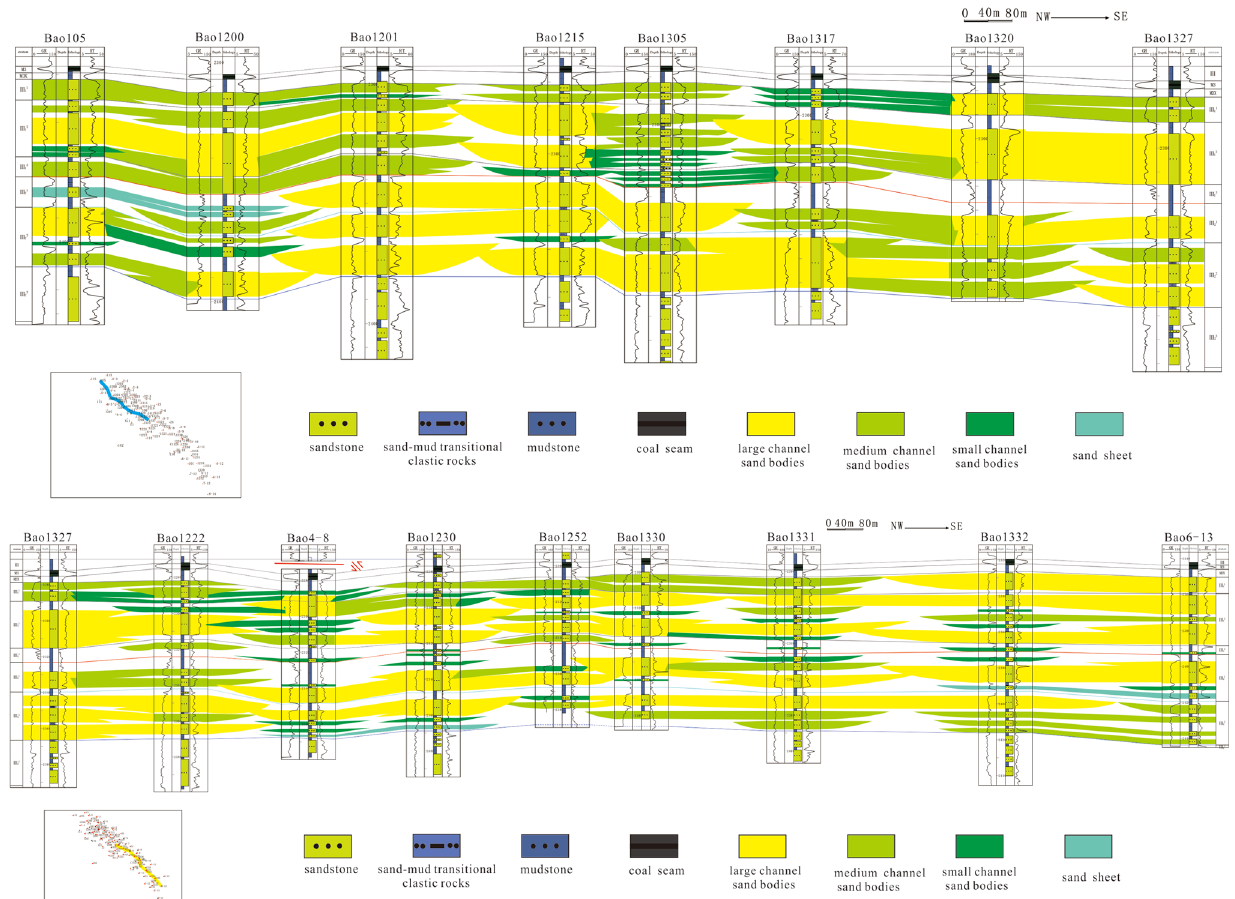
Fig. 7 Vertical section of sedimentary petrofacies of III oil-bearing interval of Sanggonghe Formation in Baobei block, Baolang